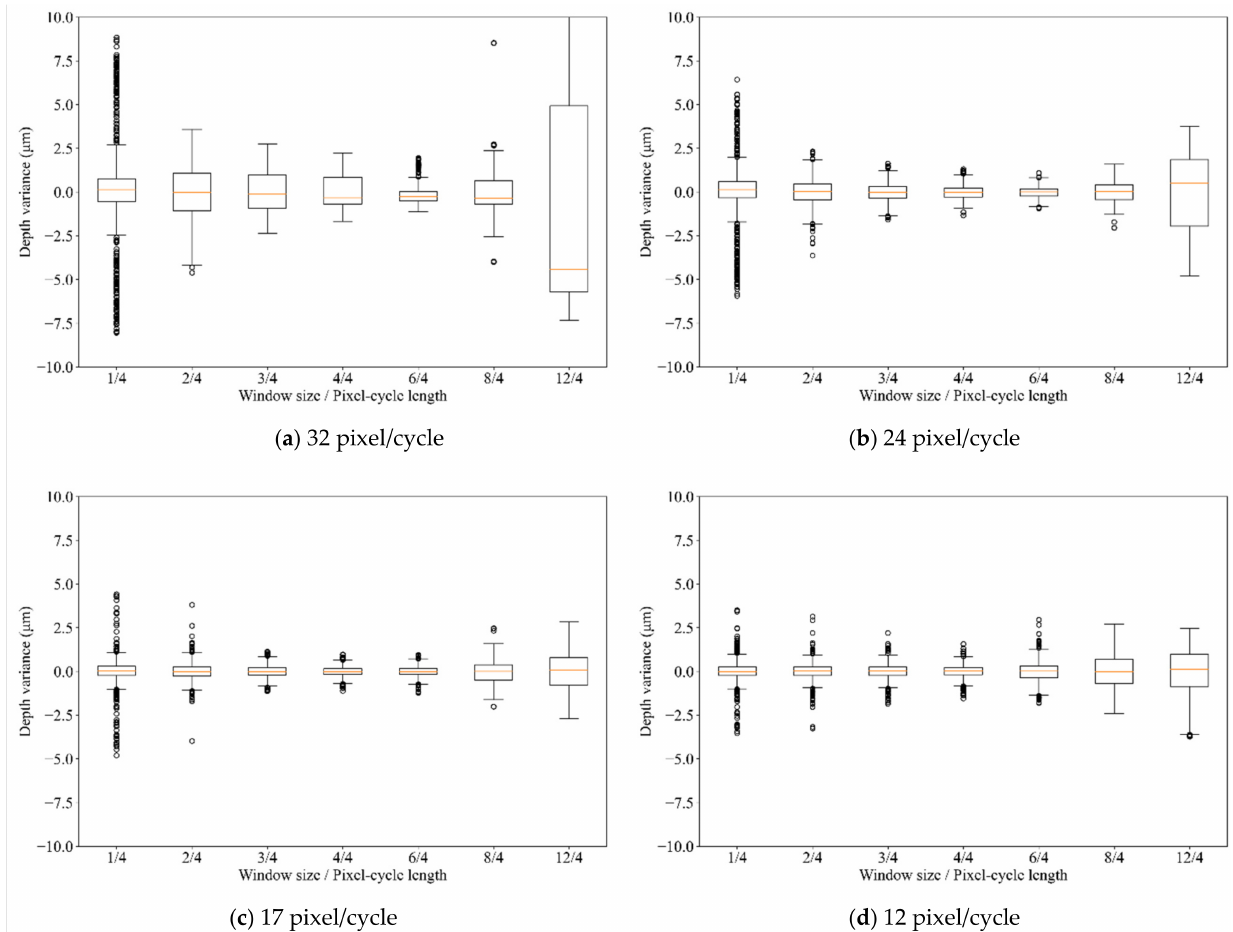
Figure 9. Residual distribution at each window size for each pixel-cycle length.